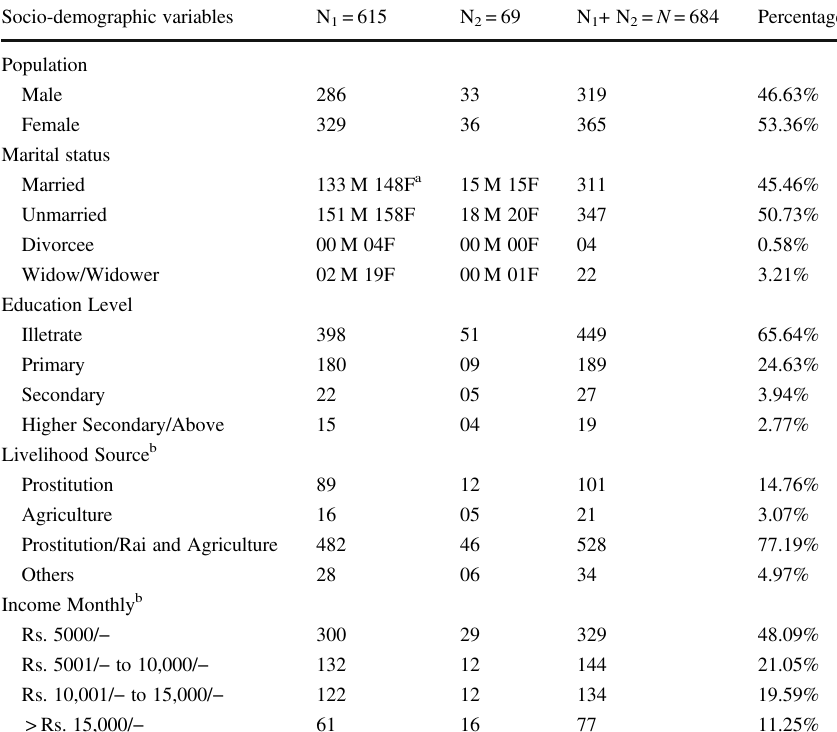
Table 1 Socio-demographic characteristics of respondents Socio-demographic